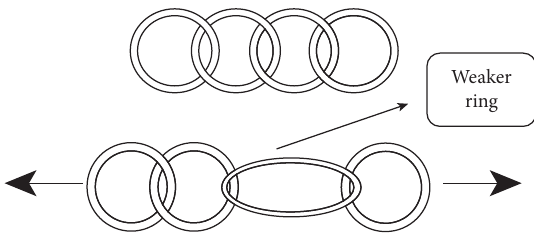
Figure 3: The concept of seismic design [17].